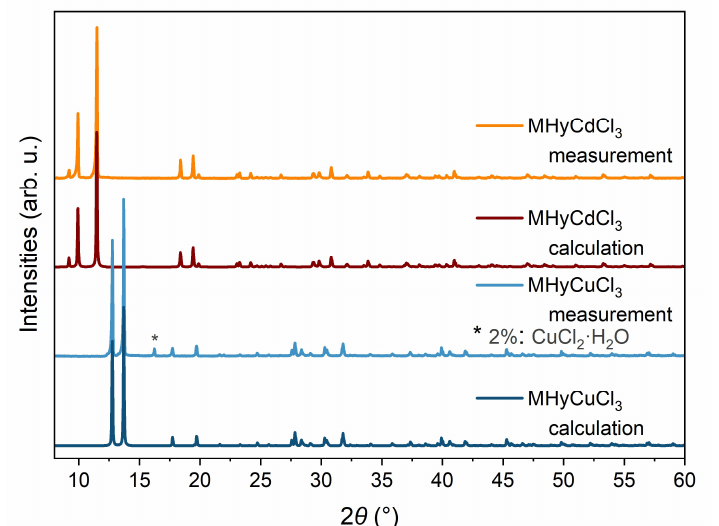
Figure 2. The comparison of the experimental and calculated using Pawley method PXRD patterns for MHyCdCl 3 and MHyCuCl 3 samples showing the quality of phase purity; * the additional phase is marked with an asterisk.